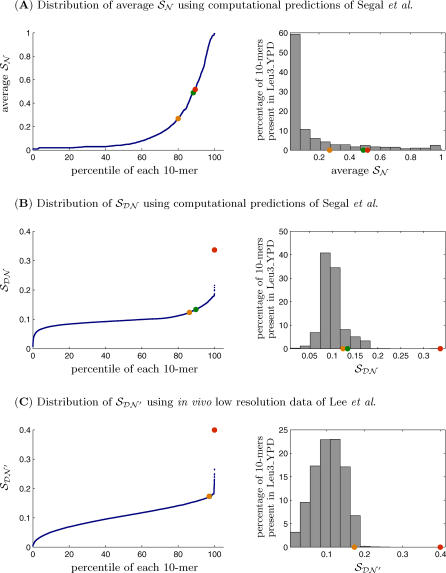
Distribution of S℘N℘, S℘D℘
N℘, and S℘D℘
N℘ ′ in the Sequence-Set for Leu3 Profiled in YPDThe distribution of scores over each unique 10-mer occurring in the Leu3_YPD sequence-set shown as a percentile plot (on the left) and as a histogram (on the right) computed according to: (A) S℘N℘ (averaged over each 10-mer) using predictions from computational model of Segal et al., (B) S℘D℘
N℘ using predictions from computational model of Segal et al., and (C) S℘D℘
N℘ ′ using low-resolution nucleosome data from Lee et al. The three colored dots marked on each figure indicate the positions of the only three 10-mers matching the Leu3 motif CCGGNNCCGG present in Leu3_YPD. The red dot corresponds to CCGGTACCGG (see text). The mass to the right of the dots in each graph reveals the fraction of 10-mers scoring higher.